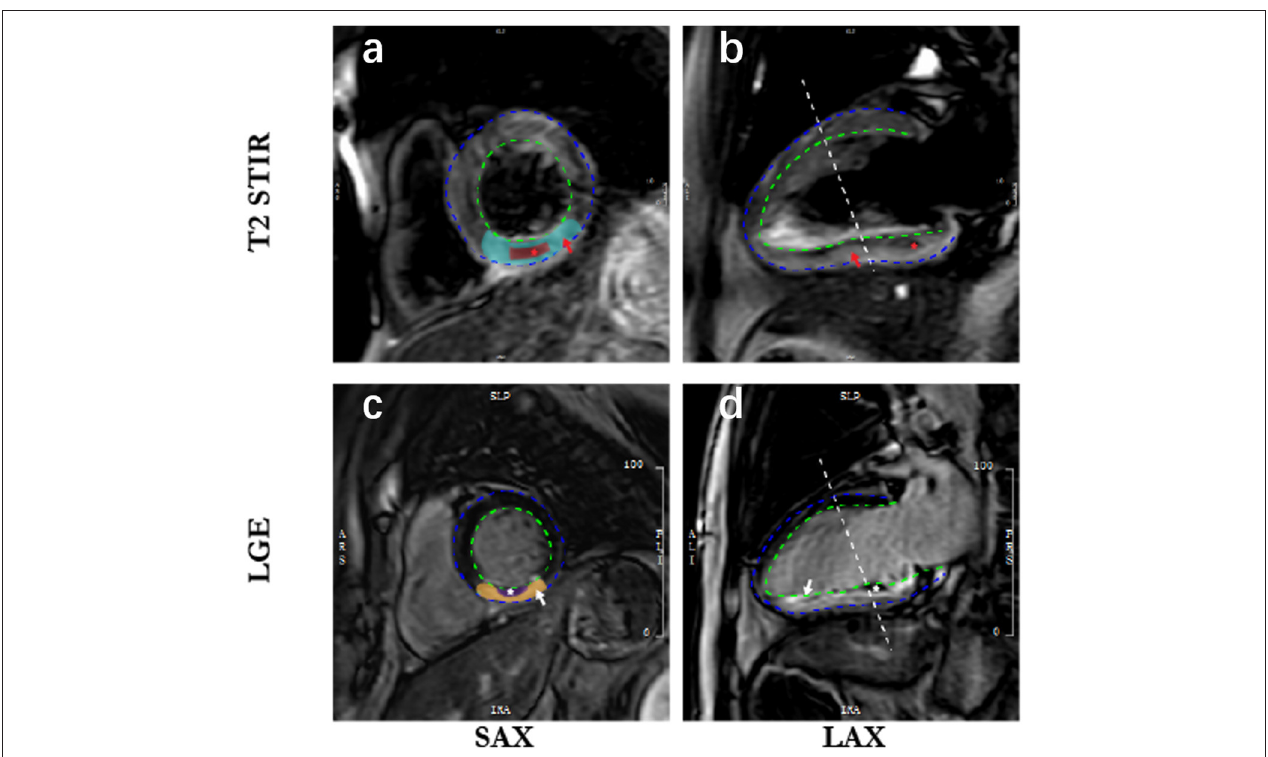
FIGURE 1 | Cardiac magnetic resonance imaging in patients with acute myocardial infarction. SAX, short axis; LAX, long axis; LGE, late gadolinium enhancement. The blue dotted line is epicardium; the dotted green line is endocardium; (a) indicates myocardial edema (blue-green zone) defined as high-signal myocardium within the territory of the culprit’s vessel; (b) shows the intramyocardial hemorrhage (red star) in the hyposignal region within the edema; (c) is infarction (yellow zone) defined as hyperenhanced myocardium, and corresponding infarct size is quantified and normalized to the left ventricle mass; 1 (d) represents microvascular obstruction (white zone) defined as a hypo-enhanced area within the infarcted-related